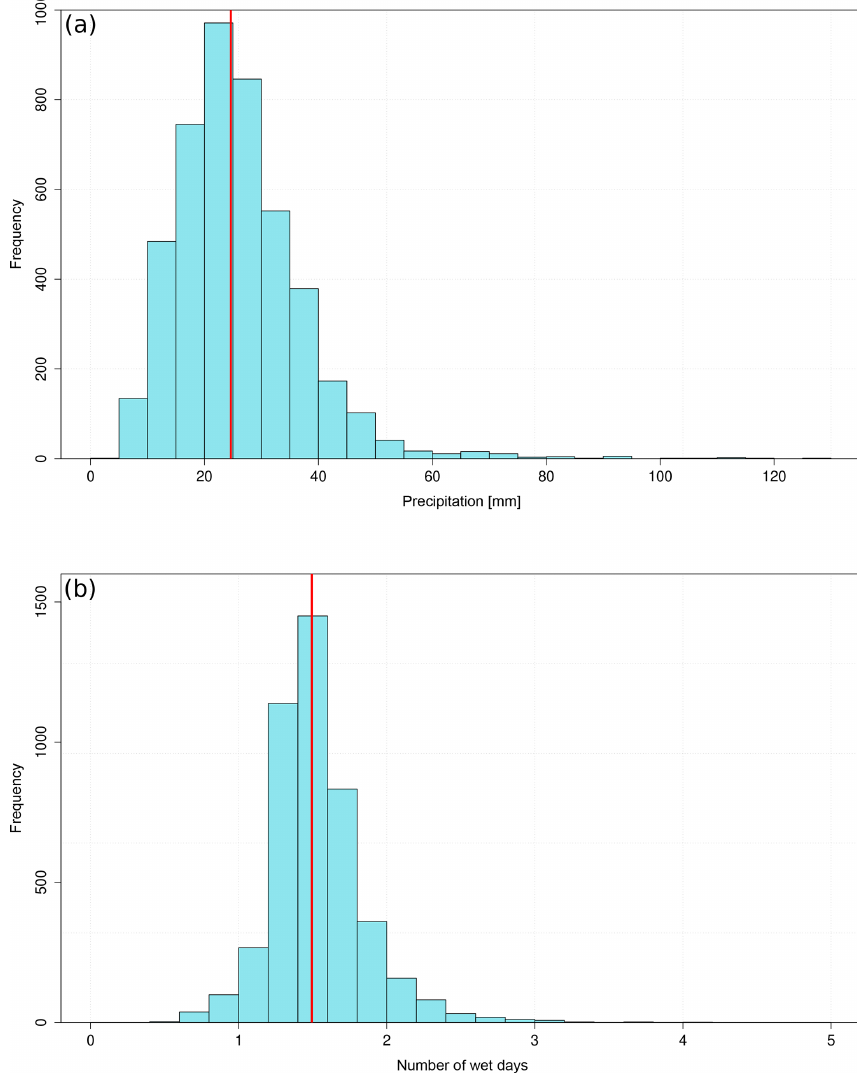
Figure 2. The distribution of the representativity error of precipitation (a) and the number of wet days (b) . The red line indicates the